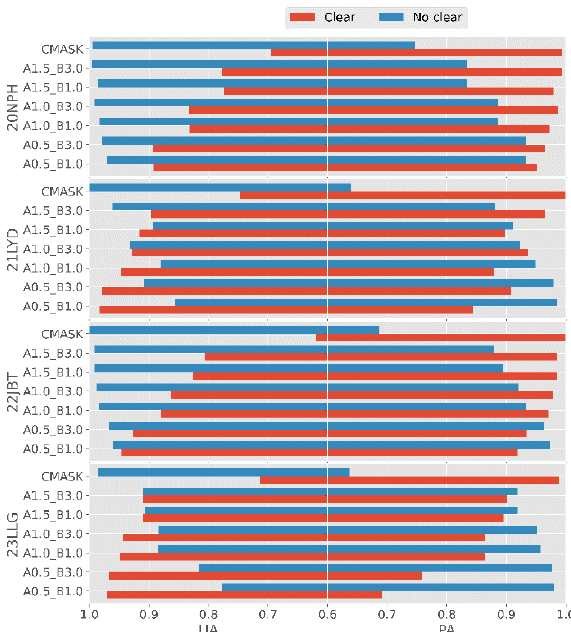
Figure 5 User's accuracy (UA) and Producer's accuracy (PA) for CMASK and different combinations of A and B parameters values in ATSA algorithm considering two classes: Clear